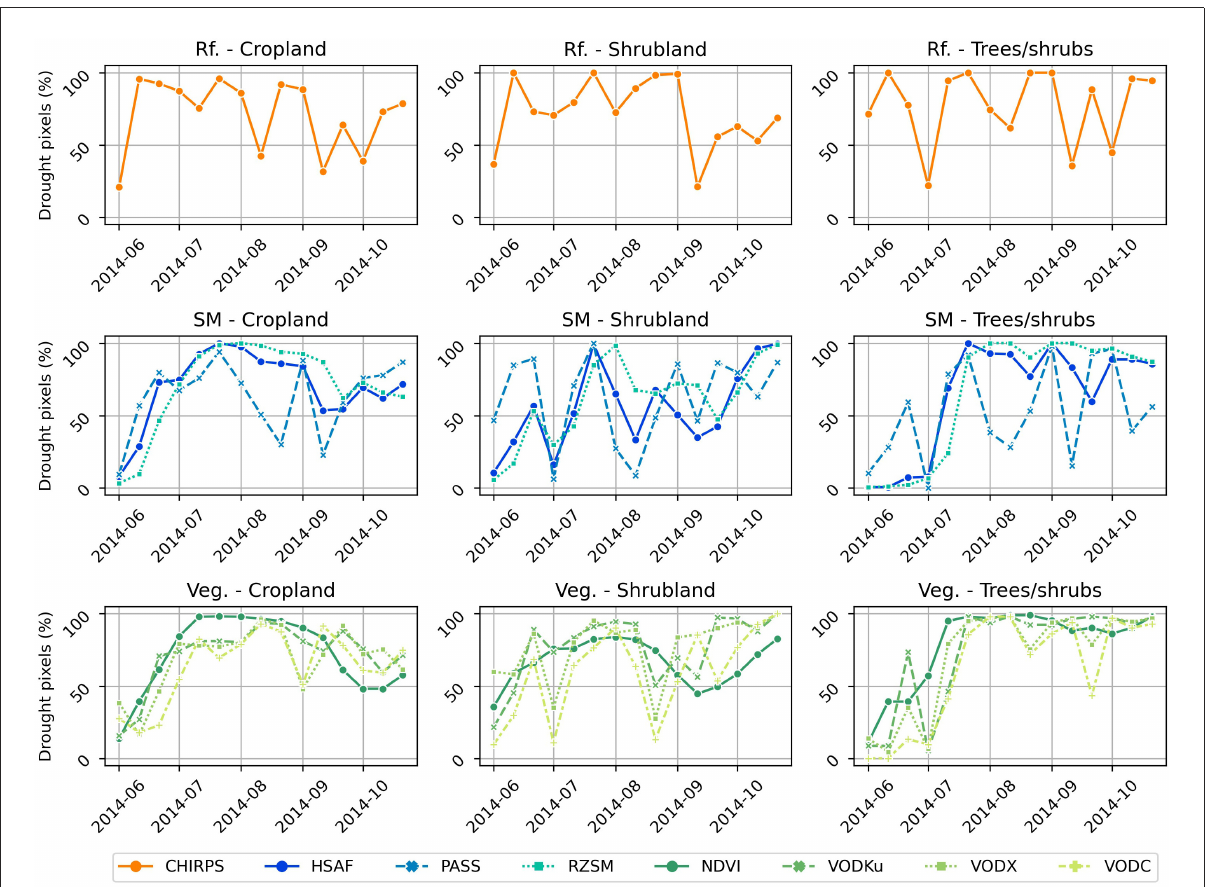
FIGURE3 Pixels under drought over the duration of the 2014 drought in Senegal for rainfall, SM and